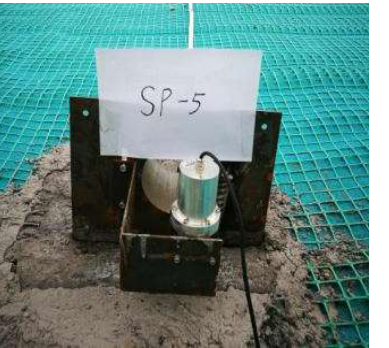
Figure 11. Pull-wire displacement sensor and station.